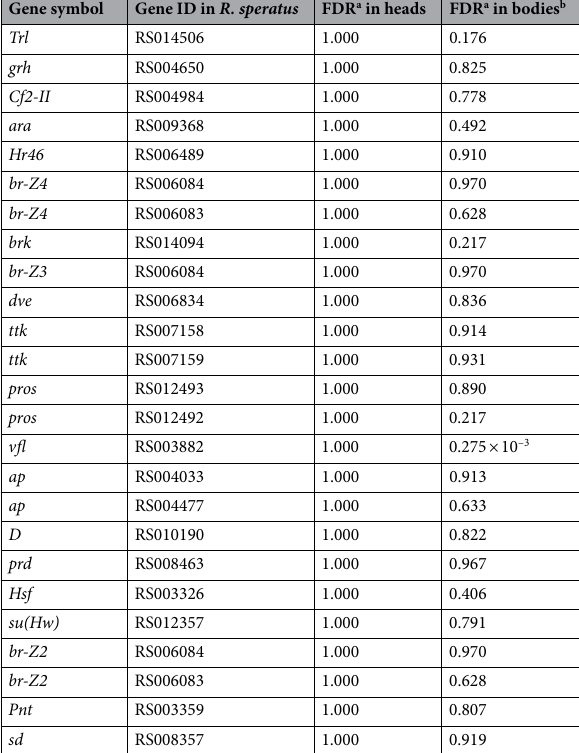
Table 2. Transcription factors with putative binding sites detected in the R. speratus genome and their expression differences between sexes. a FDR based on GLM with sex using edgeR. b Body: the thorax and abdomen.